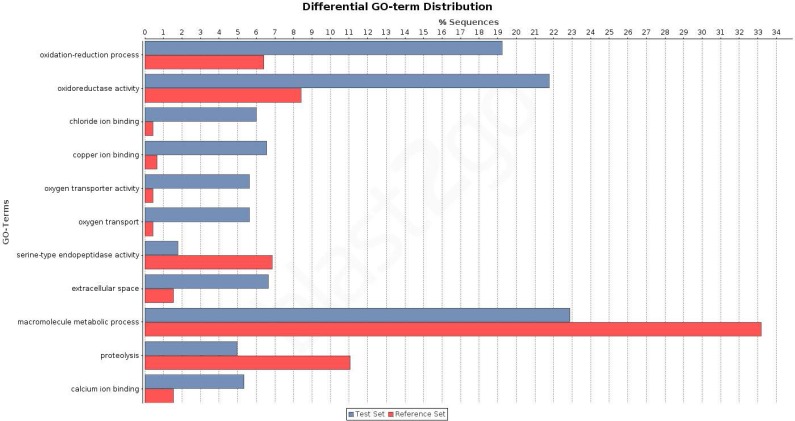
Differential distribution of GO terms across tissues.Differential distribution of the GO terms of the transcripts from leg and palp (Venn sections I, II and IV; in blue) and ovary (sections III, V, VI and VII; in red). Analysis conducted excluding HK and CEG encoding genes (1,523 transcripts over 5,390).